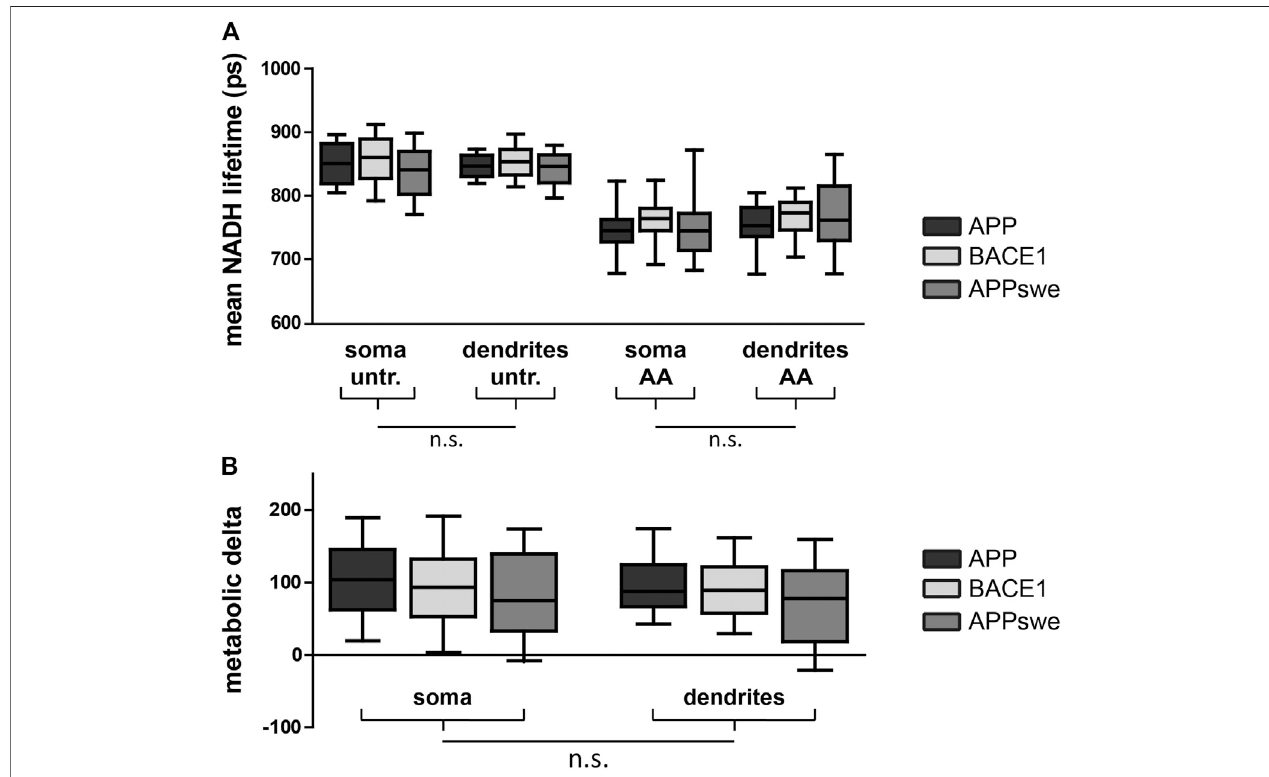
FIGURE 3 | PHNs show similar NADH lifetime and metabolic delta in soma and dendrites. Mean NADH lifetime (A) and metabolic delta (B) (surrogate for mitochondrial respiration) in soma and dendritesofprimary hippocampal neurons overexpressingAPP (black), BACE1 (light gray), or APPswe (dark gray). Calculated as the difference between untr and AA of (A) . Signi fi cances were analyzed between conditions (APP, BACE1, and APPswe) and between regions (soma and dendrites) of the same condition and combined conditions (APP, BACE1, and APPswe pooled together) on the single-image level using two-way mixed ANOVA and the Mann – Whitney post hoc test with the Bonferroni correction for multiple testing (n > 50 images). No signi fi cance was found for any aforementioned conditions. All box plots show interquartile range, with the line indicating the median and the whiskers 10 – 90%. (C) The effect size of matrix pH on τ mean was quanti fi ed by correlating τ mean with mitochondrial matrix pH in individual neurons pretreated with antimycin A (5 µM) (n (cid:2) 5, > 100 neurons, τ : − 0.190, p (cid:2)